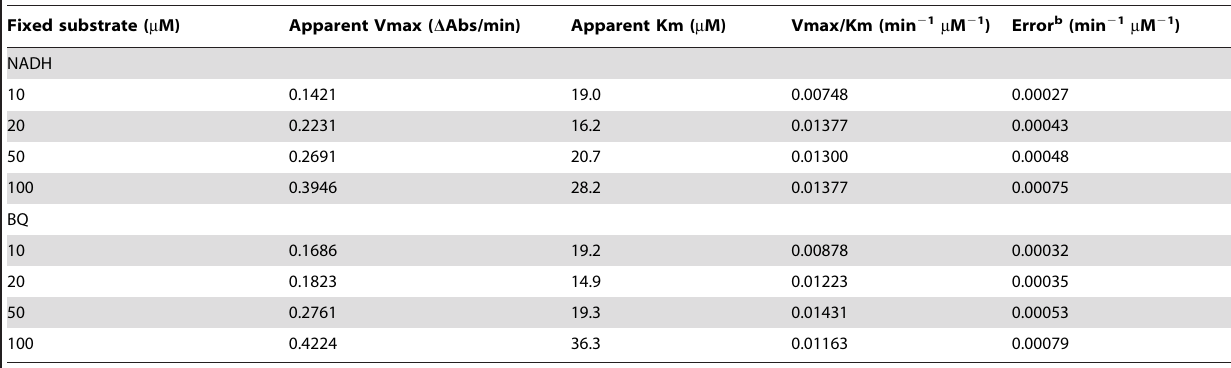
Fixed substrate ( m M)